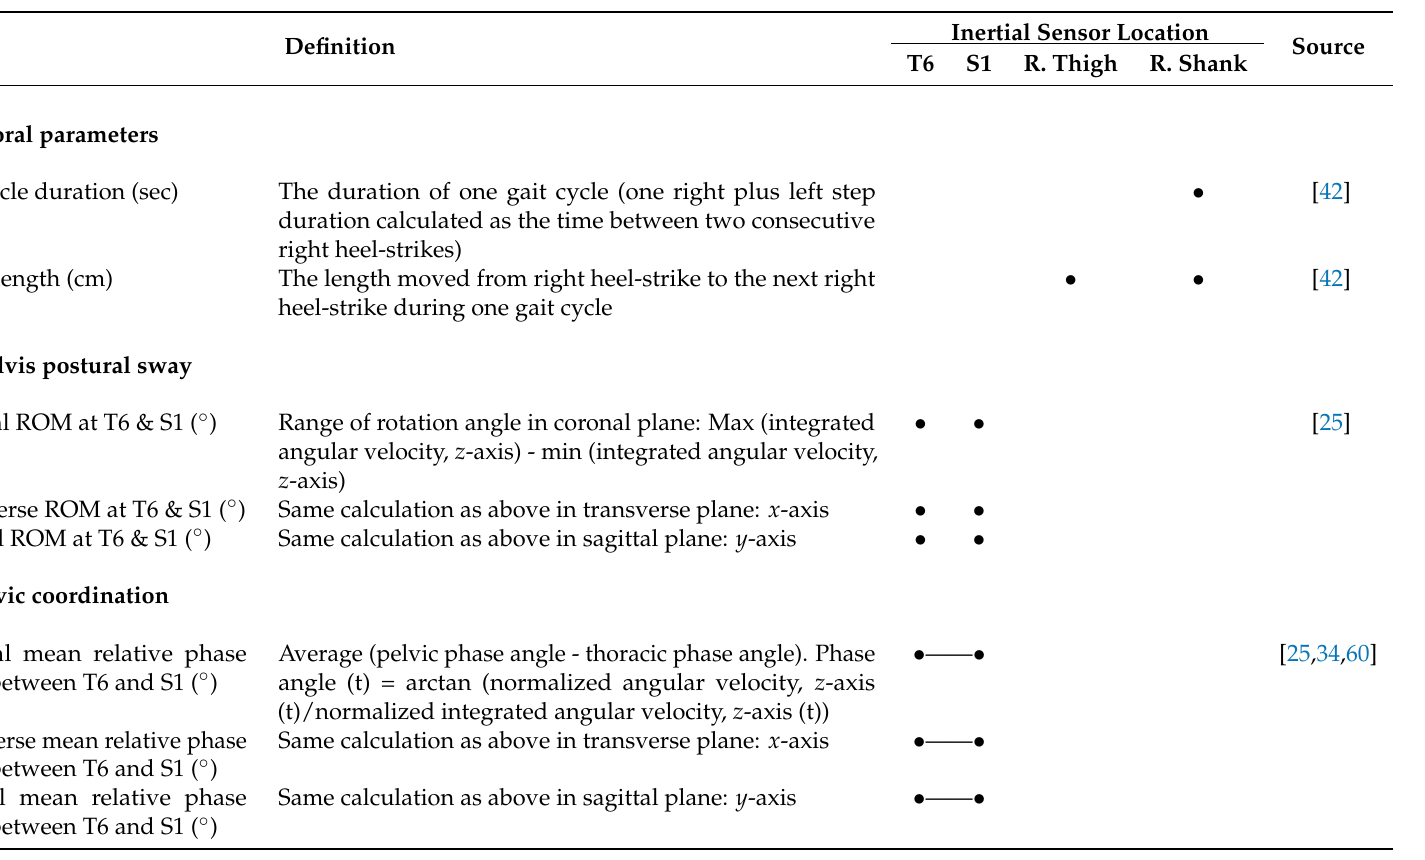
Table 1. List and definitions of gait parameters calculated from inertial sensor data. In each row, location of sensors used for calculating the parameters are indicated by ’ • ’ with relevant source reference. Connected dots indicate pairs of sensors used